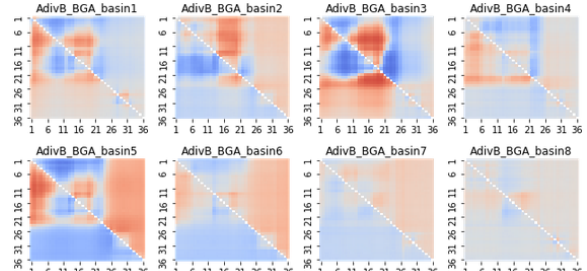
Figure 9. A/B-correlations for the parameter BGA classified by basins